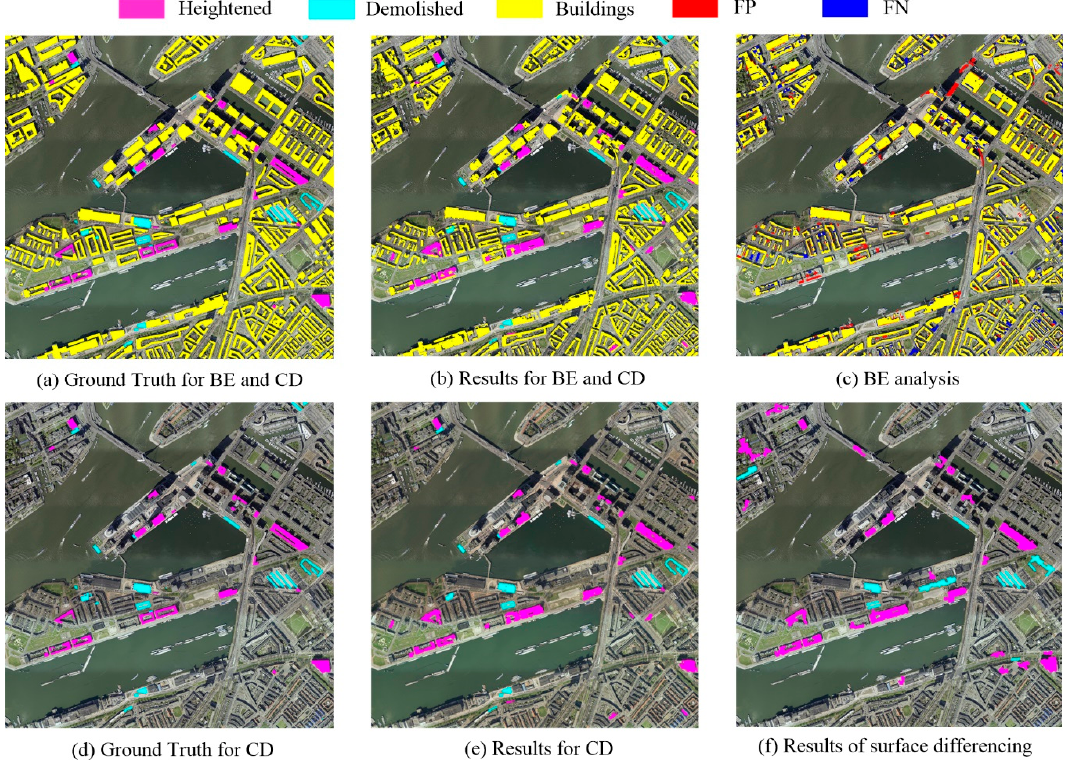
Figure 8. Experimental results of Rotterdam data. (BE: building extraction; CD: change detection). Remote Sens. 2020 , 1 2 , x FOR PEER REVIEW